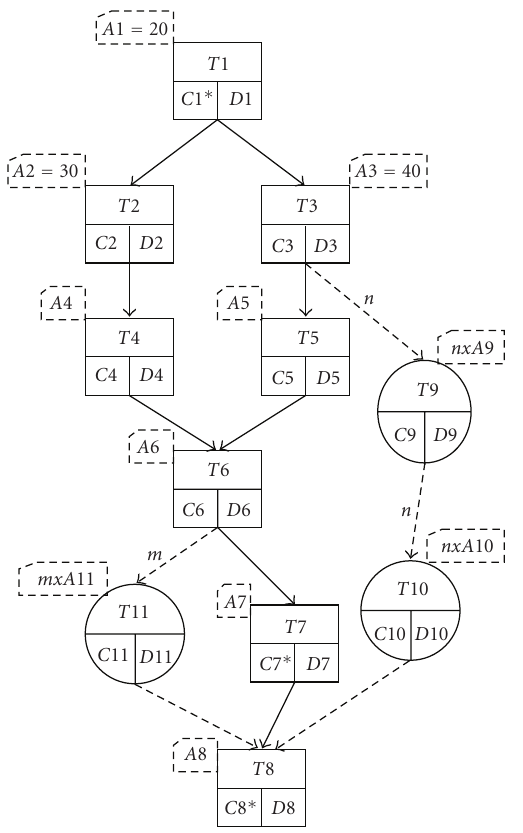
Figure 4: New model for dynamic